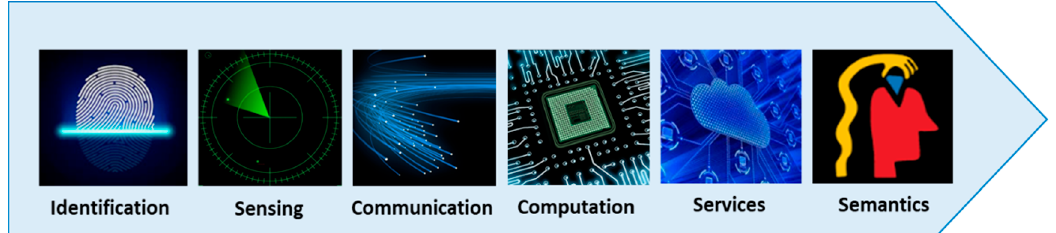
Figure 3. Illustration of a value chain for IoT-based waste management systems.